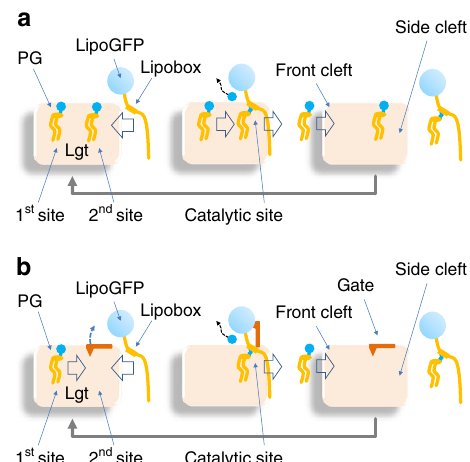
Figure 7 | Two putative transacylation mechanisms of Lgt. In scheme ( a ), PG in its binding site II of the central cavity will come in contact with the lipobox of the peptide substrate bound to the H 103 GGL region in the central cavity for transfer of the diacylglyceryl moiety. G1P will leave through the periplasmic exit, and modified peptide substrate (product) will exit out of the side cleft. The PG molecule in binding site I will move to site II for the next round of catalysis, as just before the next prolipoprotein substrate moves in. In scheme ( b ), the conformational change seen in the loop connecting TM6 and TM7 helices on the periplasmic side suggests the presence of a gate (seen in form-2 crystal; shown in red) between PG-binding sites I and II. In this case, the conformational change, like induced-fit, will open the gate to allow PG in the binding site I to move to the site II and to take part in catalysis. After the product leaves, the gate will close again, and the cycle is